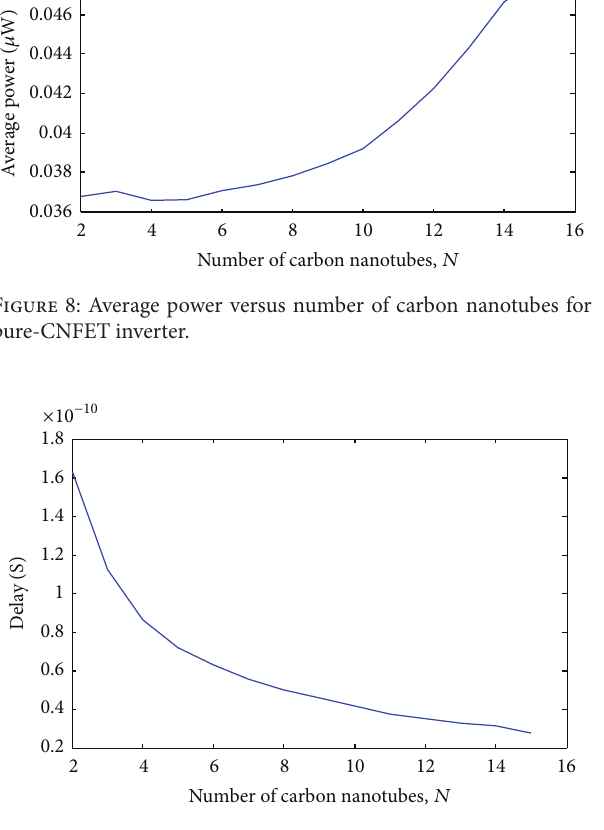
Figure 9: Delay versus number of carbon nanotubes for pure- CNFET inverter.